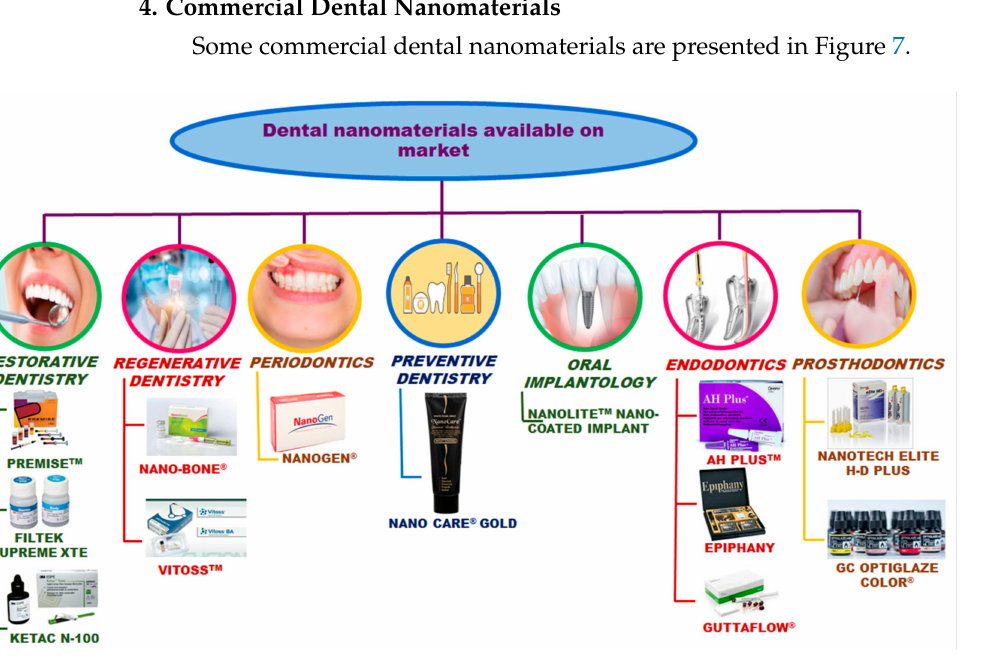
Figure 7. Dental nanomaterials available on the